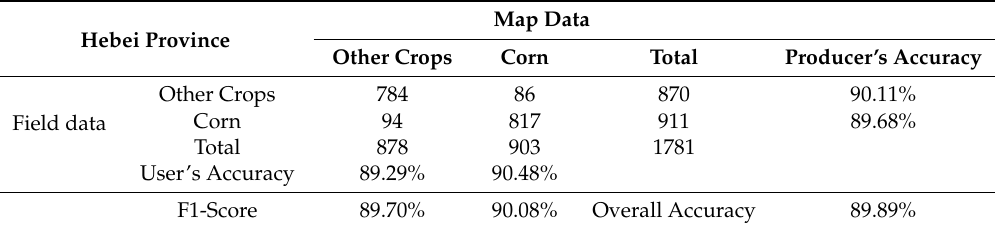
Figure 10. Corn map of Hebei Province, which integrates the pixel-based result generated with synthetic aperture radar (SAR), optical images in Google Earth Engine (GEE) and the object-based segmentation ( a ). The right column represents the detailed maps of Baoding ( b ) and Xingtai ( c ), and the specific location is labeled in ( a ) with two red rectangles. Table 1. Testing point confusion matrix of the Hebei corn map.